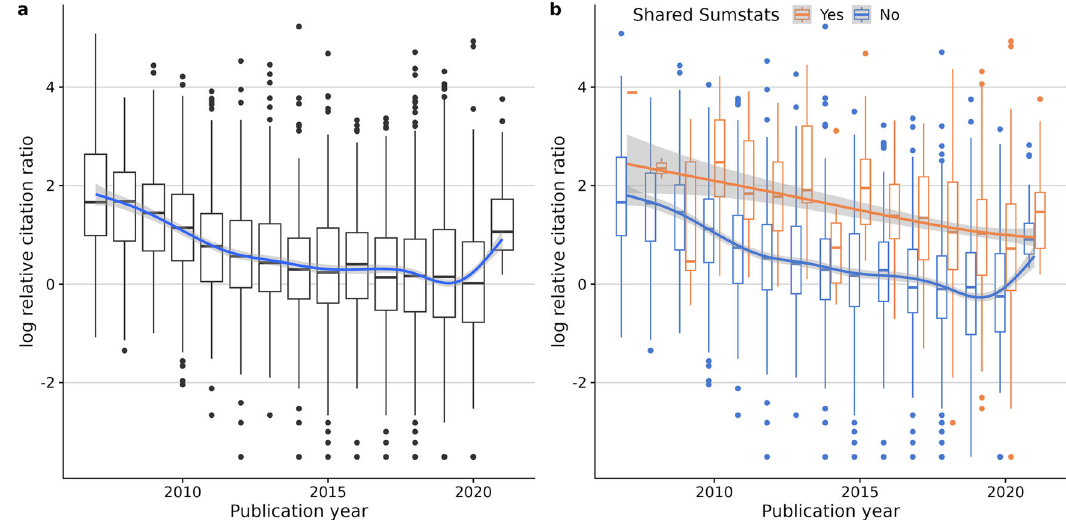
Fig. 2 Citation patterns over time (2006 – 2021), measured in log relative citation ratio. a All GWAS. b Split by summary statistics sharing status. Sharing studies are consistently more cited than non-sharing studies. Lower and upper box hinges represent the 25th and 75th percentiles, respectively. The whiskers extend for 1.5 * IQR from each hinge, and the horizontal line within the boxes represents the median.